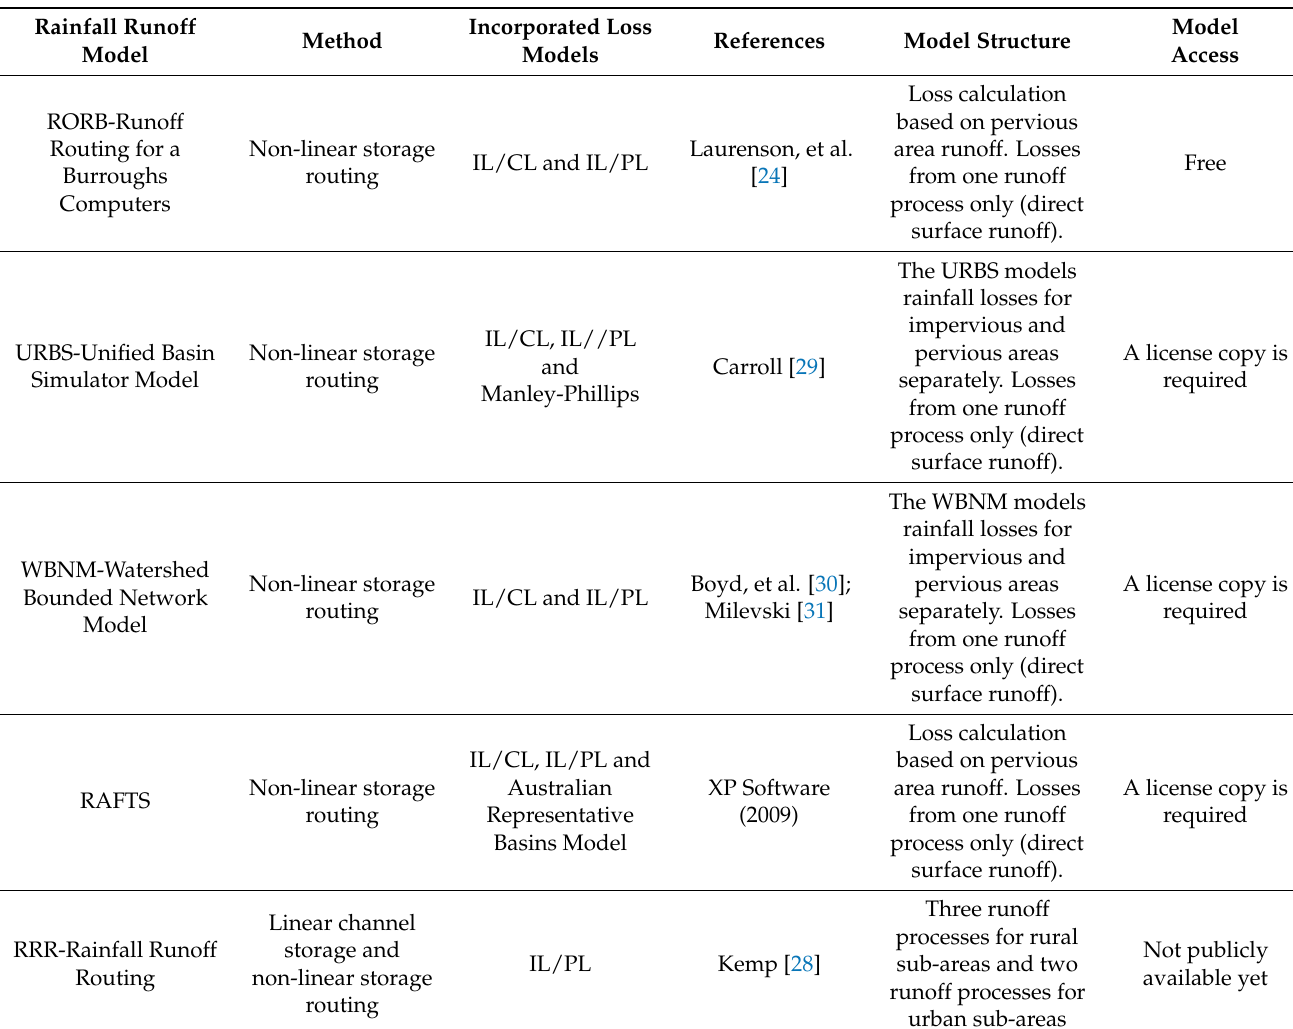
Table 1. Empirical loss models used in rainfall runoff